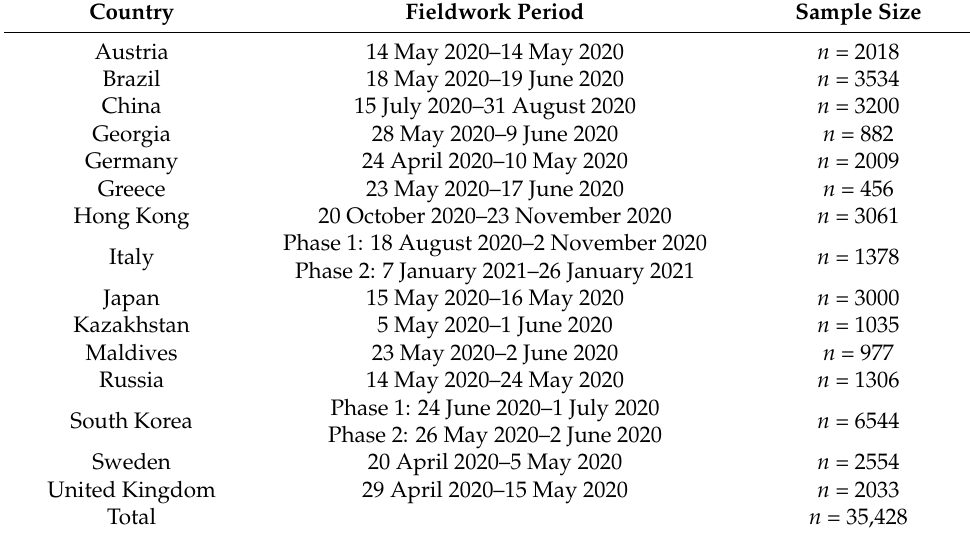
Table A1. Survey period and sample size by country/region.